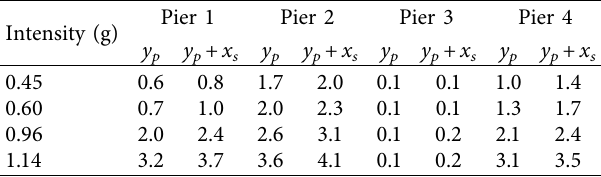
Table 6: Maximum relative displacement (unit: mm) between each pier and continuous girder under diferent experimental earth- quake intensities (in y direction).